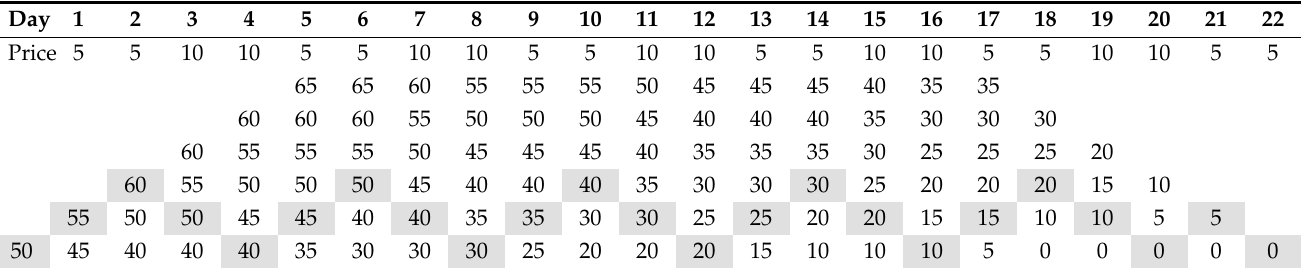
Table 3. Payoff of Dynamic